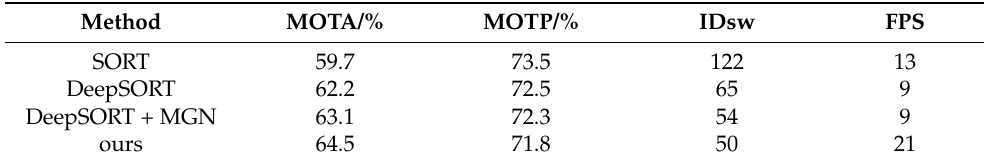
Table 2. Comparison of multi-object tracking effects of different